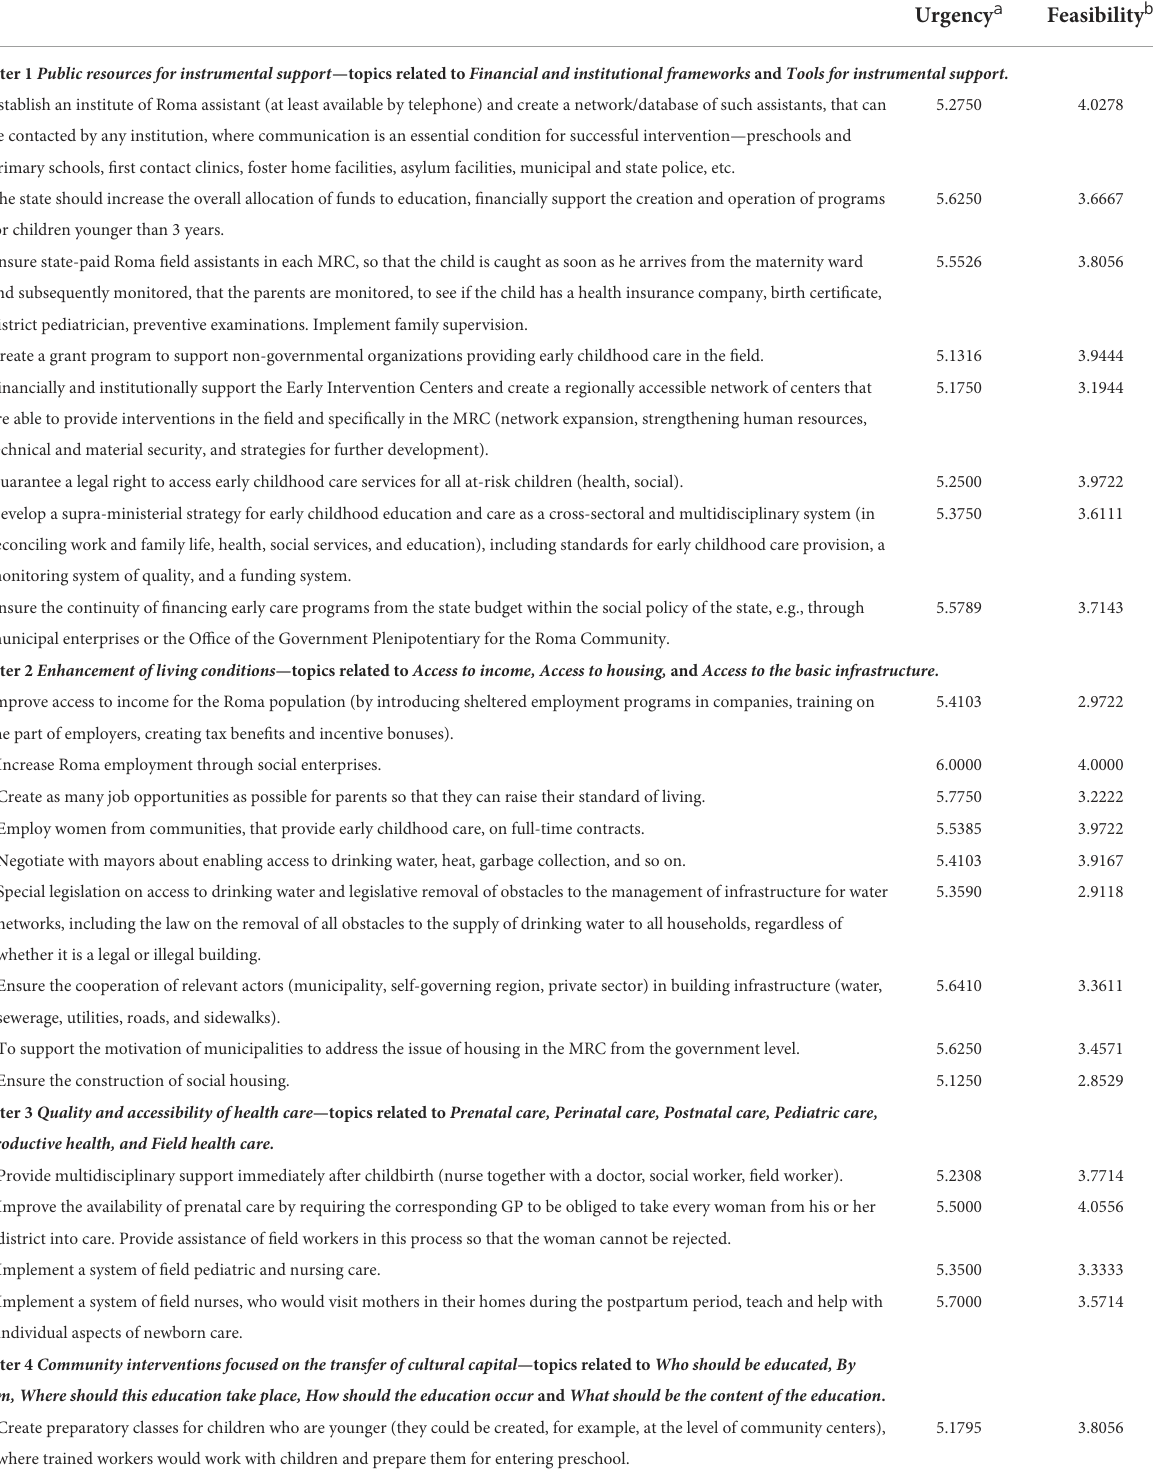
TABLE 3 List of urgent but not feasible measures and interventions targeting early childhood health and development in MRCs in Slovakia according to professionals working with the target population. Proposals by